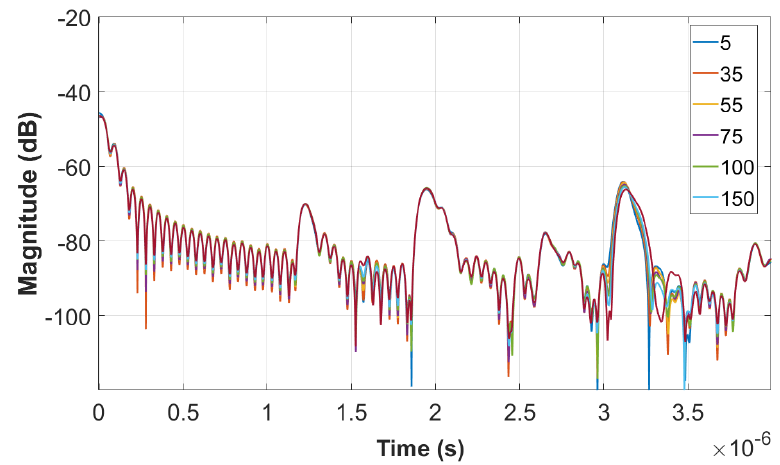
Figure 15. Time domain response from the measured VNA data after compensation of the free space propagation loss, antennas’ reflection loss, and antennas’ near−field coupling.